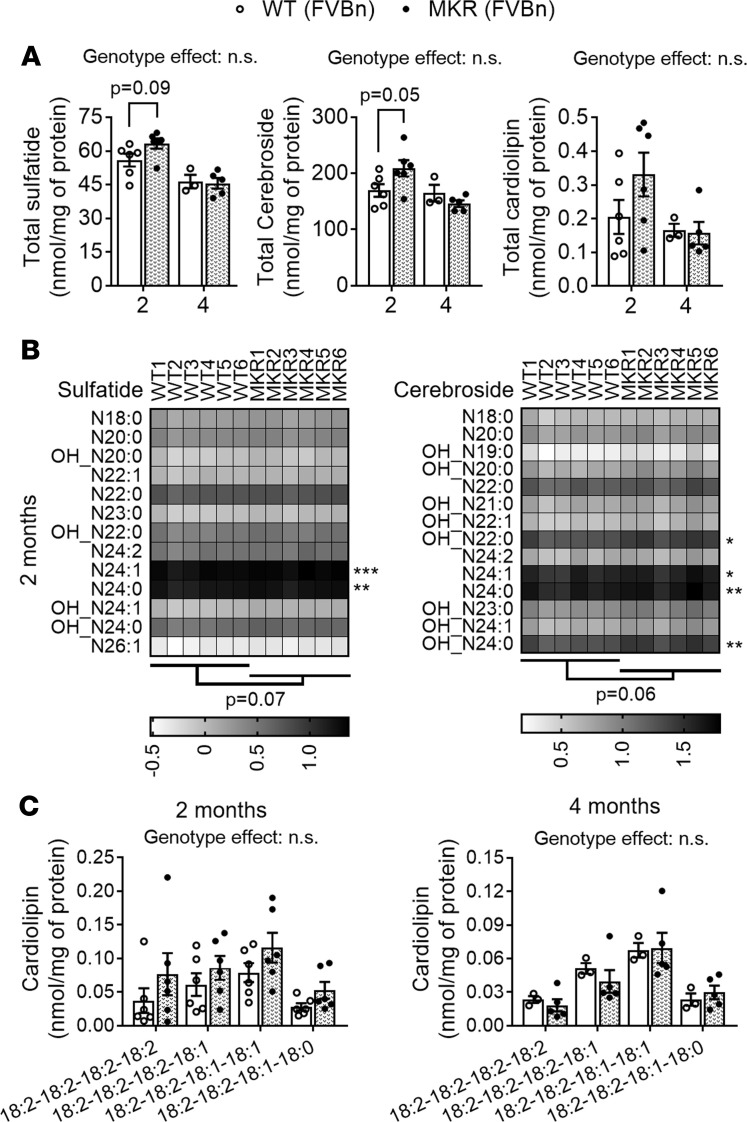
Hyperinsulinemia and insulin resistance do not alter nerve mitochondrial/myelin lipid homeostasis.Sciatic nerve tissue from WT (open circles/bars) and MKR (filled circles/bars) mice (both on an FVB/n genetic background) was lipid extracted and assessed by shotgun lipidomics. (A) Total sulfatide, cerebroside, and cardiolipin content from 2- and 4-month-old mice. (B) Sulfatide and cerebroside (CBS) molecular species from sciatic nerves of 2-month-old mice. (C) Cardiolipin molecular species from sciatic nerves of 2- and 4-month-old mice. Total levels of each lipid class are displayed as dot plots (WT: open circles/bars; MKR: filled circles/bars); data represent the mean ± SEM of n = 6 mice/genotype. Total levels of each lipid class were compared between genotypes for every tissue examined at each time point using 2-way ANOVA (genotype effect P values specified on top of each graph) and Holm-Šidák multiple-comparisons tests (adjusted P values specified on top of brackets). Molecular species masses expressed as nmol/mg of protein were log transformed and displayed as gray scale heatmaps. Low-abundance lipid species that made ≤1% of the total class content are not shown and were not included in statistical analyses. Although a specific mass peak may represent >1 cardiolipin molecular species, for simplicity heatmaps display only 1 (most common) lipid species for each mass (row). Molecular species within each lipid class were compared using 2-way ANOVA and Holm-Šidák multiple-comparisons tests on GraphPad Prism 7. Statistics displayed below the heatmaps comparing genotypes and next to the molecular species are based on nontransformed data.